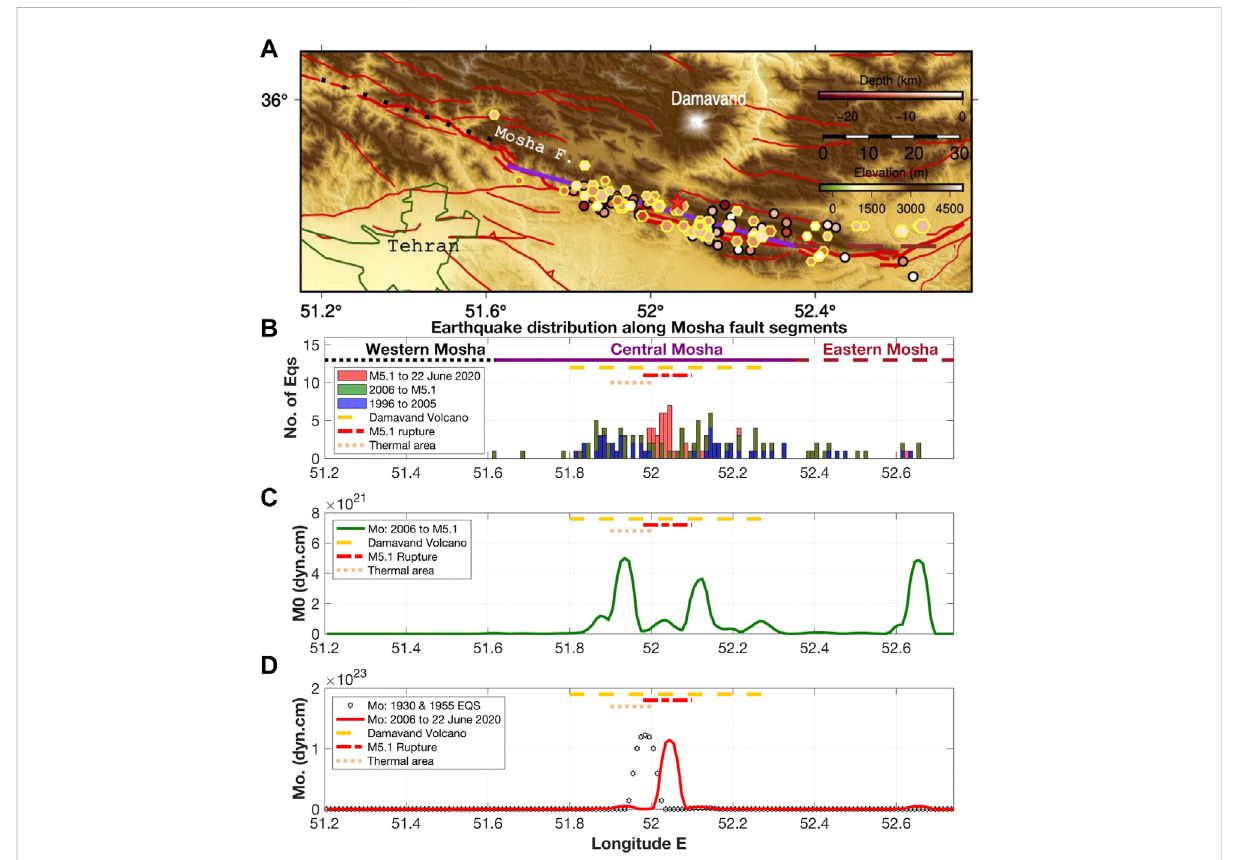
FIGURE 5 (A) Seismicitywithinadistanceof5 kmoftheMSHsince1996untiltheM5.1mainshock.Circlesandhexagonsaretheearthquakessince1996to the end of 2005and 2006 until before the M5.1, respectively. Dotted, solid, and dashed lines are western, central, and easternsegments of the MSH, respectively. (B) Histogram showing the distribution of earthquakes along the MSH. (C) Distribution of scalar seismic moments along the MSH from 2006untilbeforethe2020M5.1mainshock. (D) DistributionofscalarseismicmomentsalongMSHfrom2006until22June2020,includingthe M5.1 mainshock and 27 M ≥ 2.5 early